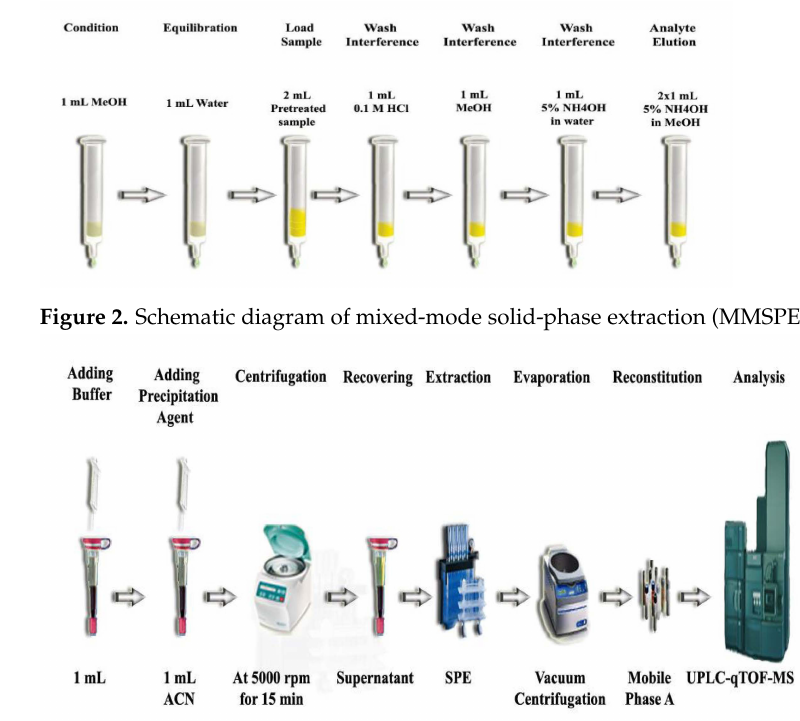
Figure 3. Schematic diagram of the analytical method used in this study.